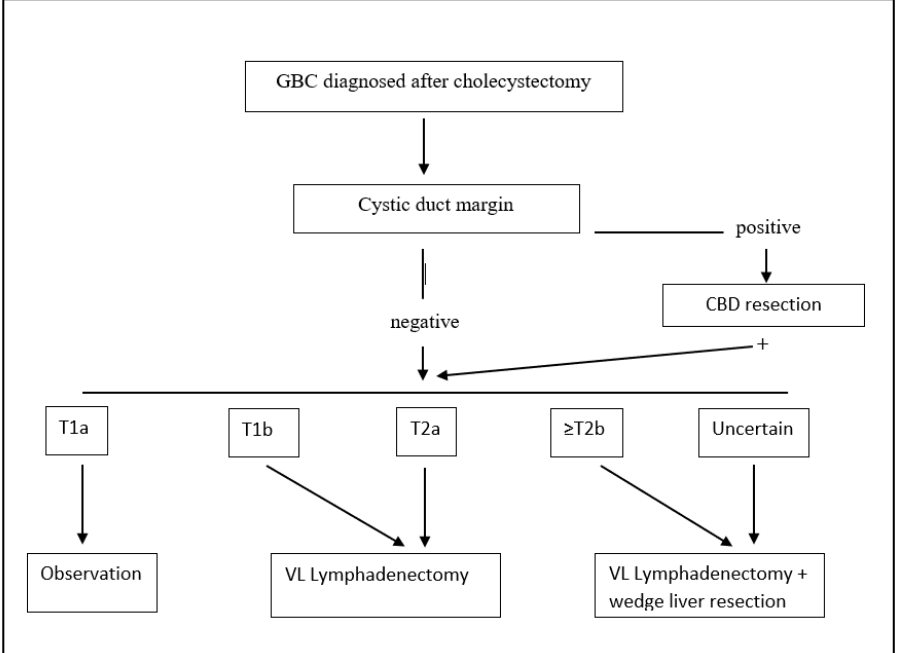
Figure 2. Treatment algorithm for incidental post-cholecystectomy diagnosis of GBC. GBC: gallblad- der cancer; VL: video-laparoscopic; and CBD: common bile duct.